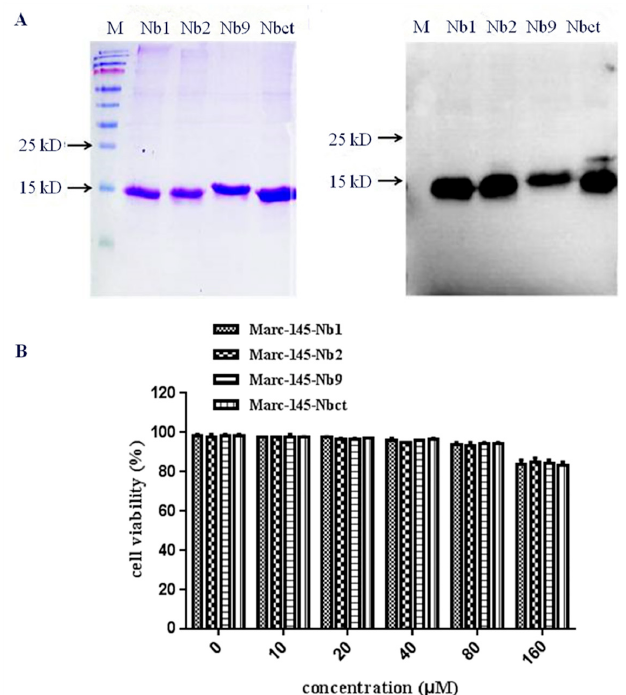
Figure 4. Purification and toxicity analysis of nanobodies. NLS-A cell-penetrating peptide fused His-tagged Nb proteins were purified and analyzed by SDS-PAGE and Western blot using His6 mAb ( A ). Cell toxicity of purified nanobodies was determined using MTT assay ( B ).